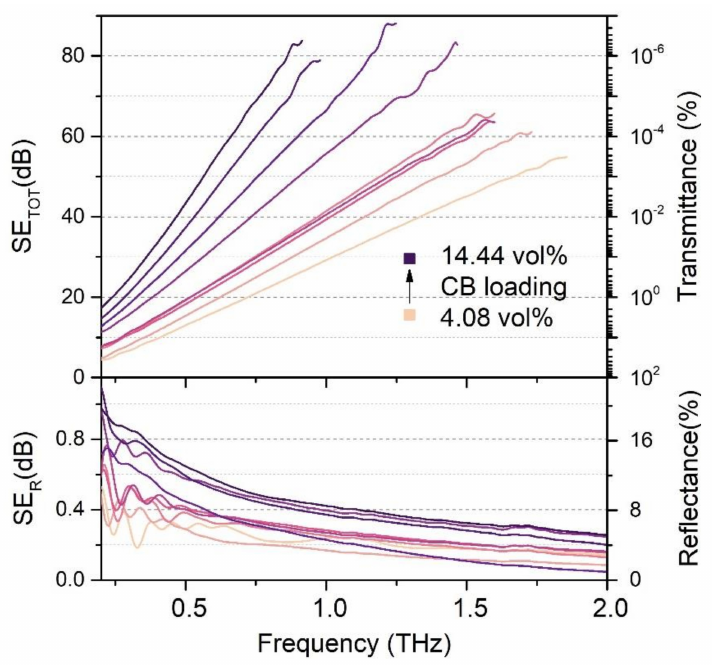
Figure 2. Basic optical properties of CB/EBA composites—transmittance and reflectance together with calculated total SE and its reflection component.